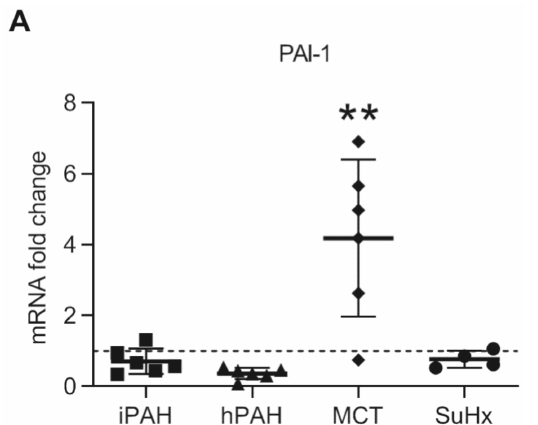
Figure 6. The mRNA expression of plasminogen activator inhibitor-1 in whole lung lysates was analyzed by qPCR. n(iPAH) = 6, n(hPAH) = 6, n(MCT) = 6, n(SuHx) = 4. ** p <